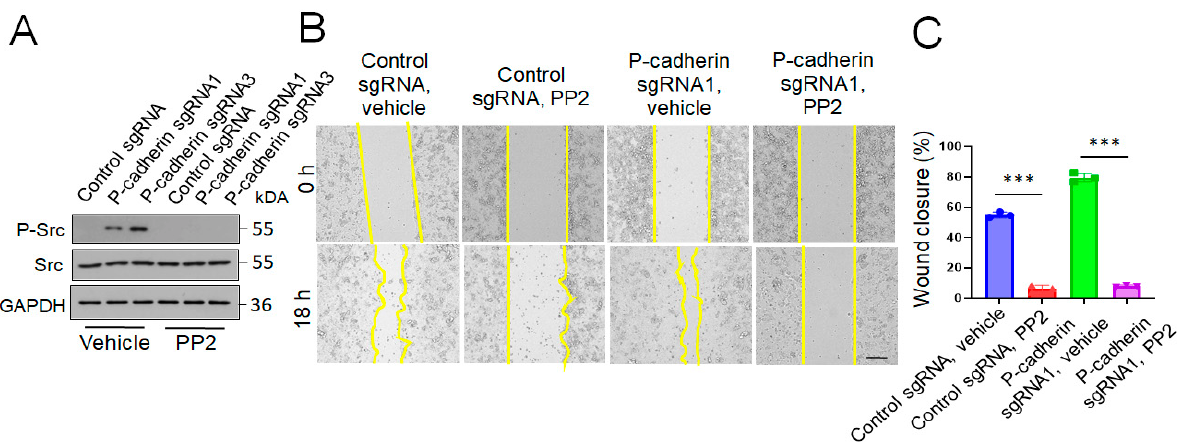
Figure 8. Src inhibition reverses the accelerated wound healing in P-cadherin deficient IEC monolayers. Control and P-cadherin knockout HCA-7 cell monolayers were wounded and allowed to migrate in the presence of either vehicle, or Src inhibitor, PP2 (20 μ M). Immunoblotting analysis demonstrates inhibition of Src phosphorylation by PP2 ( A ). Representative pictures of wounded monolayers ( B ) and quantification of wound closure ( C ) are shown. Means ± SE ( n = 4); *** p < 0.005. Scale bar, 100 μ m. The results shown are representative of three independent experiments.